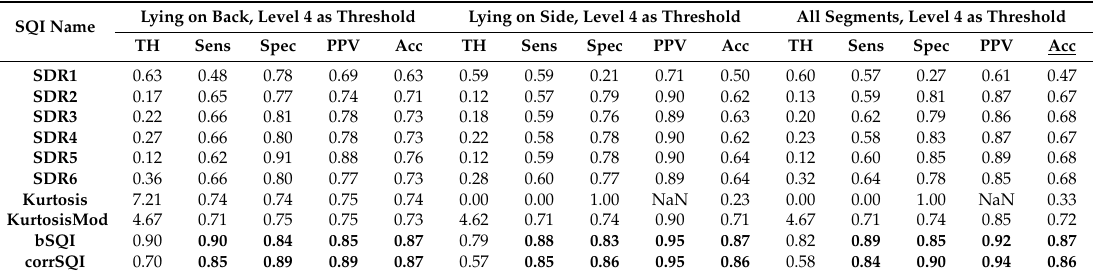
Table 6. Test results for segment classification into usable or not usable ccECG considering level 4 as threshold for usable